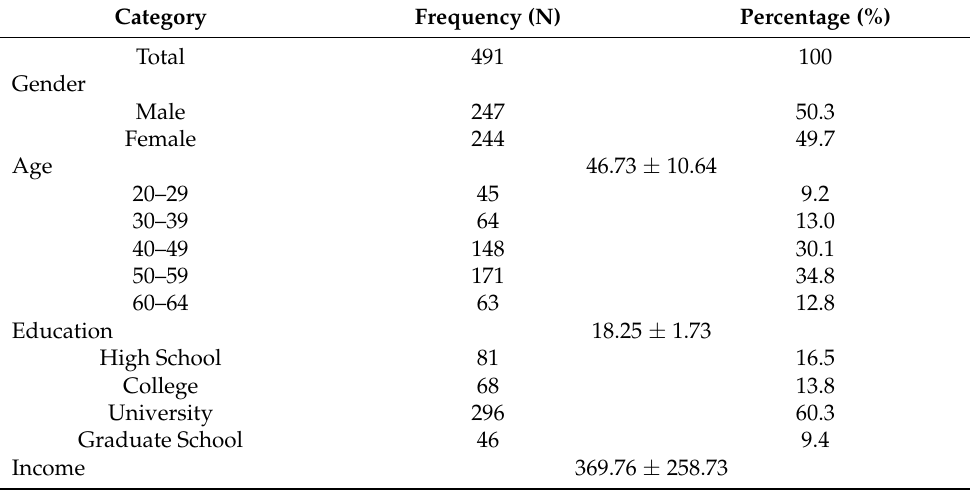
Table 1. Sociodemographic characteristics of the